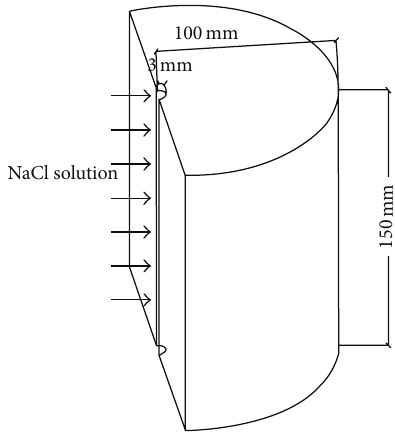
Figure 8: Schematic diagram for half of the model.